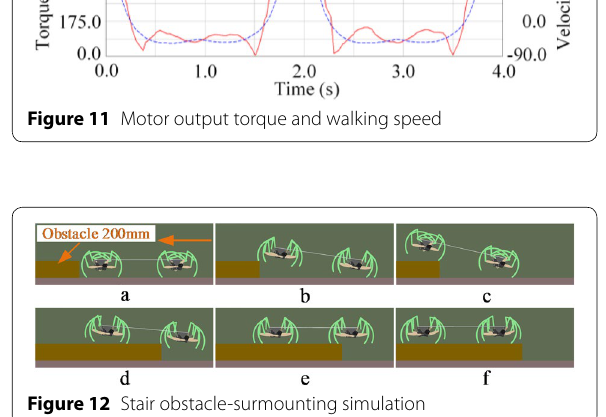
Right leg group Left leg group Right wheel Left wheel